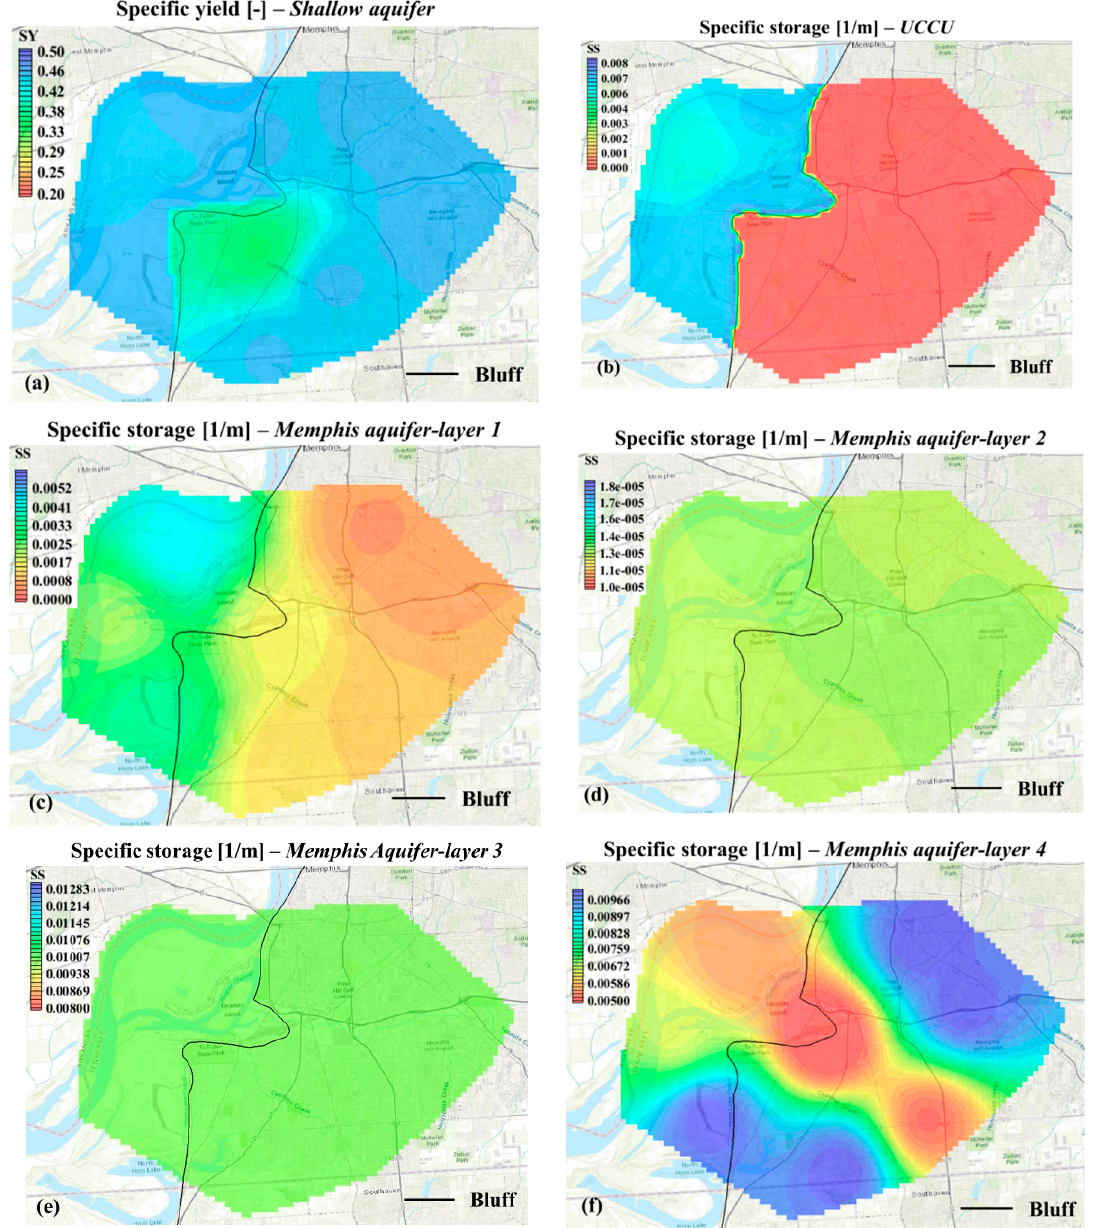
Figure A3. ( a ) The specific yield coefficient of the Shallow aquifer. ( b – f ) The specific storage of UCCU and Memphis aquifer, respectively.